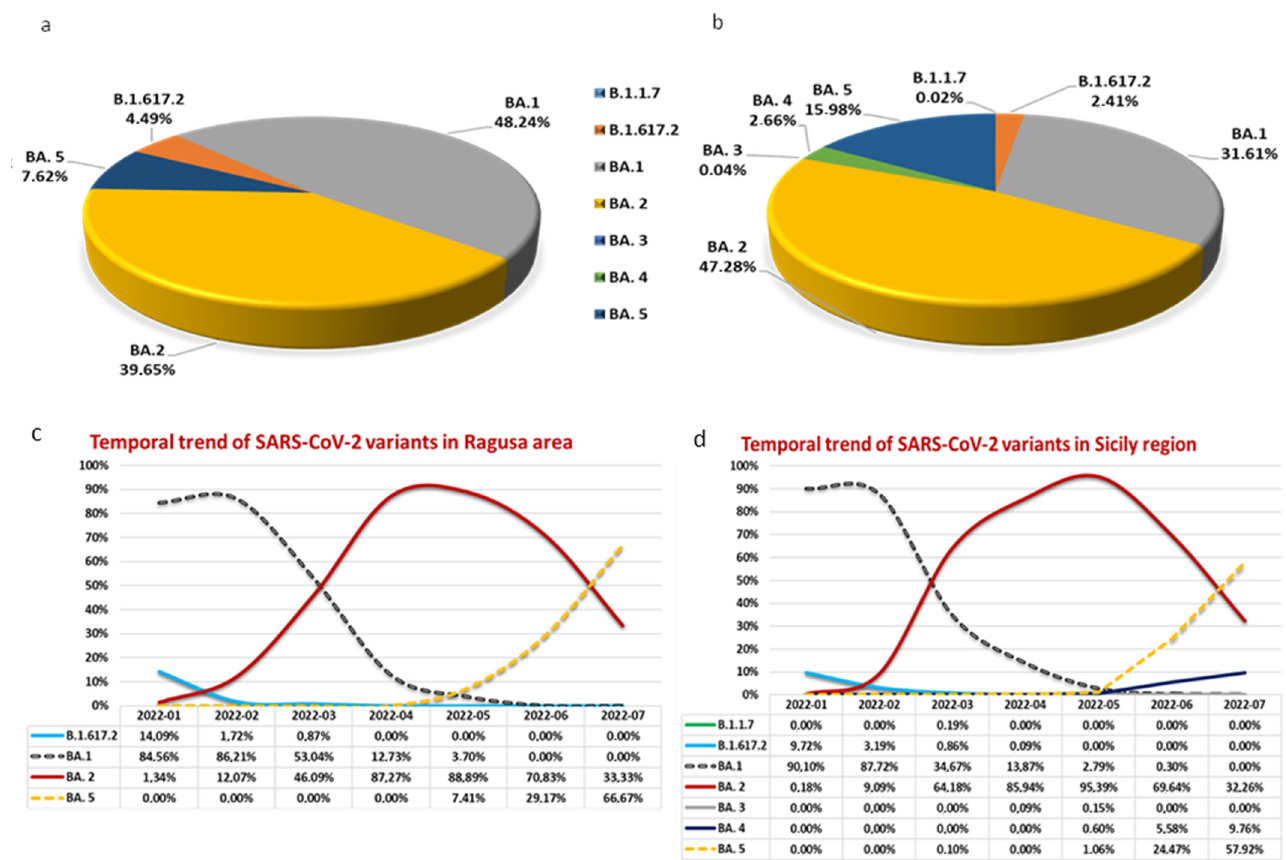
Figure 1. Variants percentages in Ragusa area ( a ) and Sicily region ( b ) and temporal trend with percentage of SARS-CoV-2 variants since 1 January to 31 July 2022 in Ragusa area ( c ) and Sicily region ( d ).